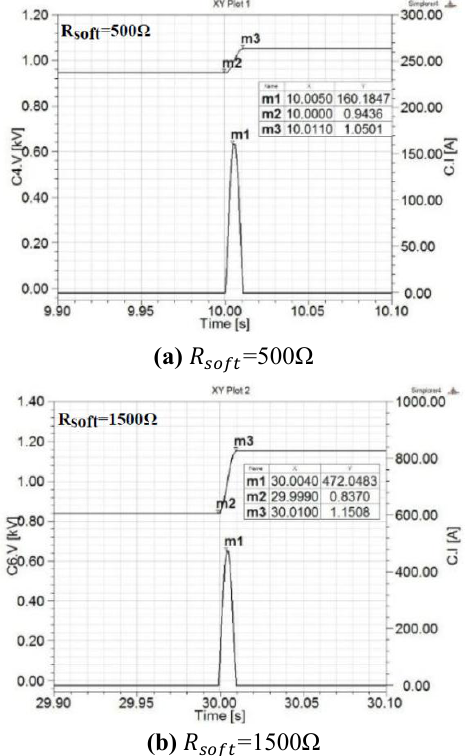
Fig. 7. The capacitor voltage of removing different soft- start resistor.